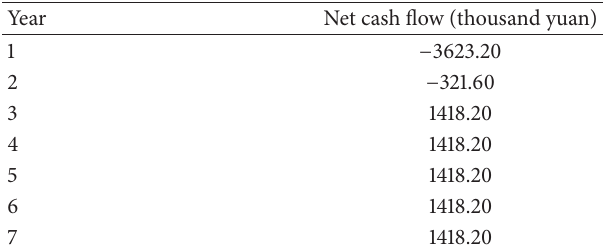
Table 7: The comparison of results by using binomial tree model with constant annualized volatility and the model from this